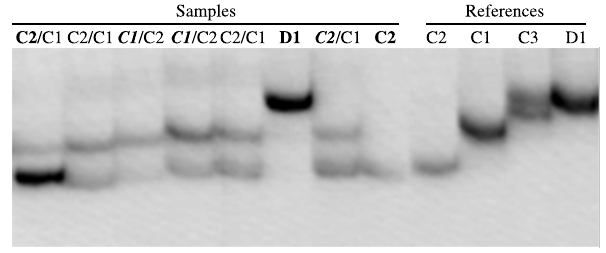
Figure 8. SSCP gel image. The image illustrates the link between band intensity and how relative abundance (dominant or background) of Symbiodinium strains was determined for individual samples. Samples in Bold =dominant, Bold /Normal=dominant/background, Normal/Normal=equal band intensities, Bold Italics /Normal=slight dominance/significant